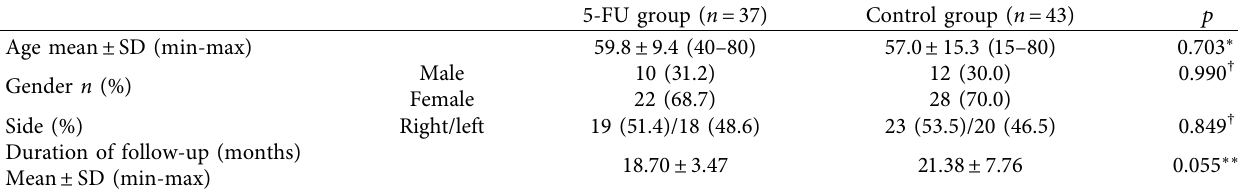
Table 1: Demographic characteristics of the 5-FU and control groups.